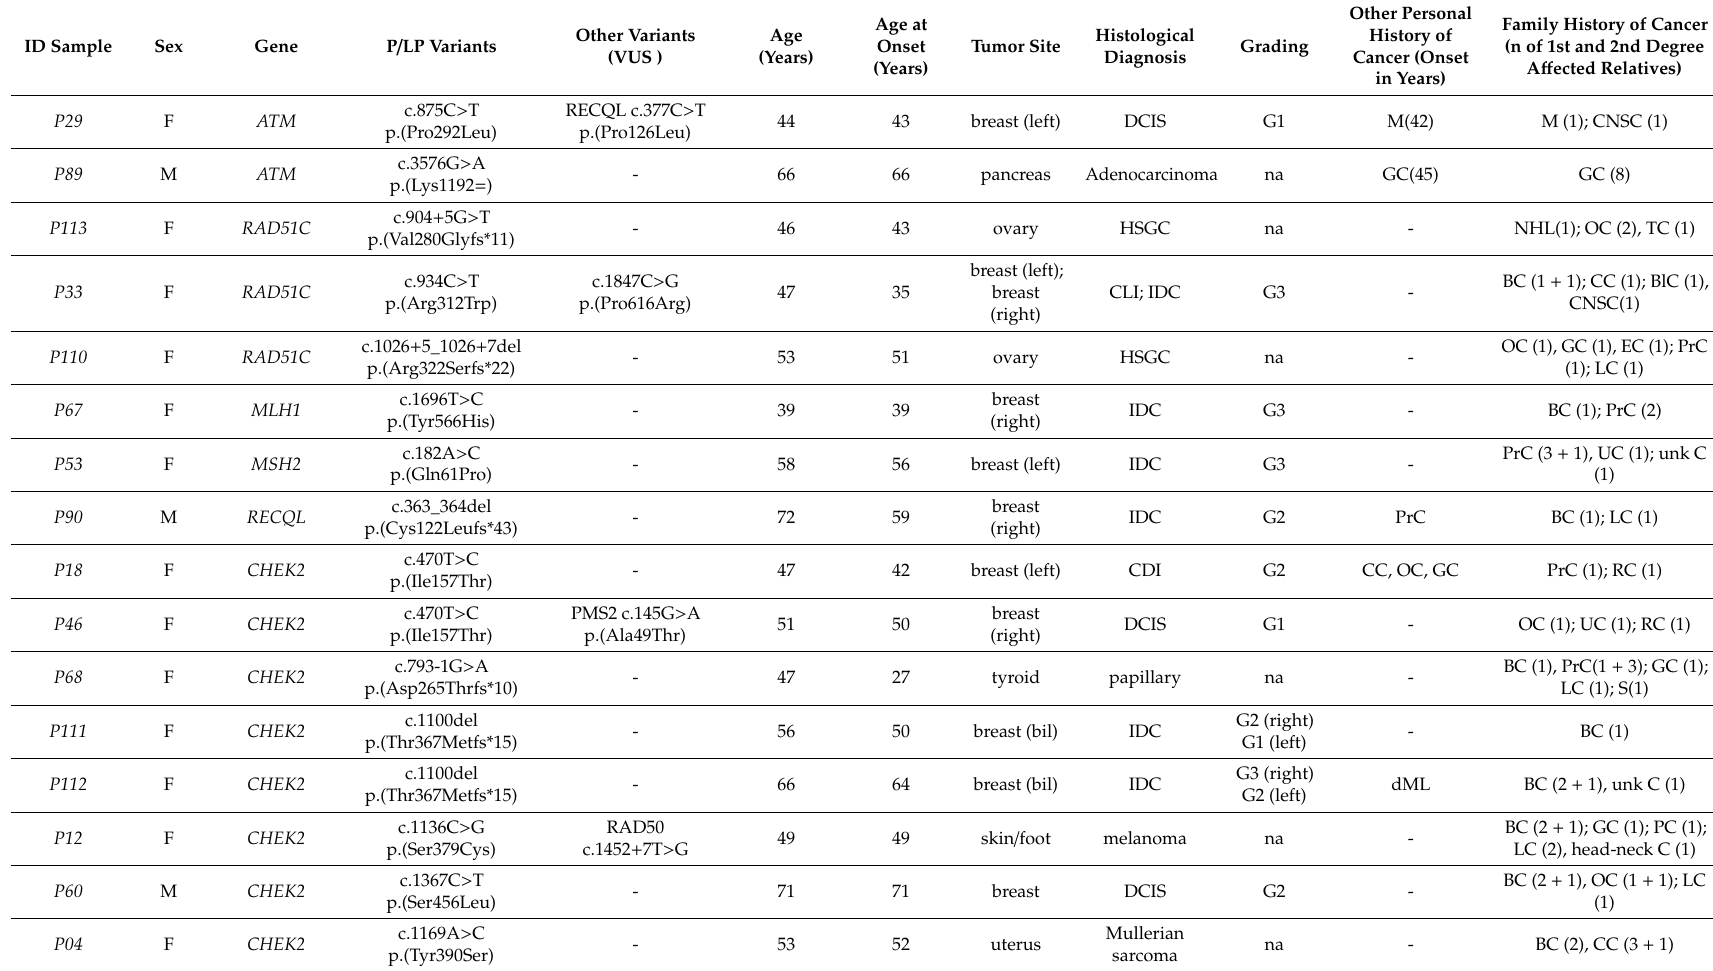
Table 4. Clinical characteristics of probands with P / PL